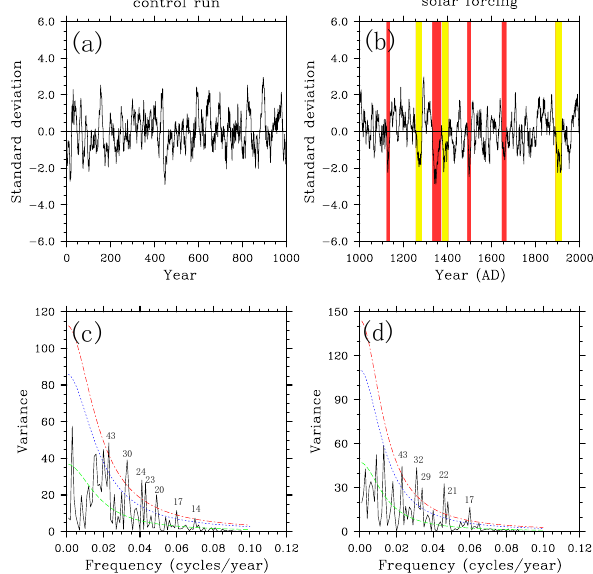
Figure 7. The 10-year running mean time series of standardized anomaly variations of rainy season precipitation rate derived from the control run (a) and solar forcing run (b) , and the corresponding spectra in the control run (c) and solar forcing run (d) . The statistical significance of the spectral peaks was tested against the red noise spectrum at the 95% (red dashed line), 90% (blue dashed line) and 50% (green dashed line) confidence levels. The severe droughts in the solar forcing run are shown with shaded bars and those that are also observed in the full forcing run are shown with red